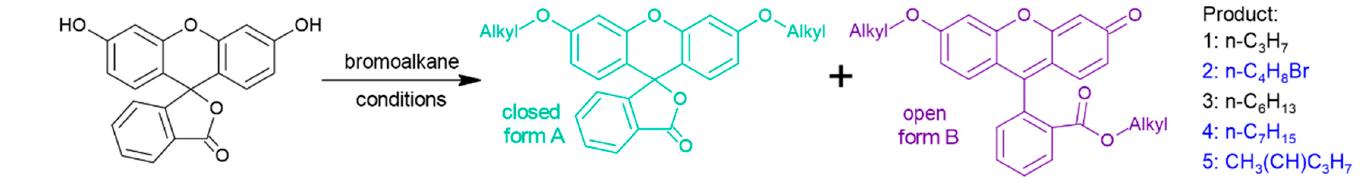
Figure 2. Preparation scheme of long chain alkyl derivatives (product A (3 ′ ,6 ′ -dialkyloxy derivative) —closed lactone ring; product B (2,6 ′ -ether–ester)—opened lactone ring) (top) with magnification —closed lactone ring; product B (2,6 (cid:48) -ether–ester)—opened lactone ring) (top) with magnification on on new, long alkyl chain fluorans (bottom). Conditions: Cs 2 CO 3 , DMF, 70 °C, 24 h for classical heat- new, long alkyl chain fluorans (bottom). Conditions: Cs 2 CO 3 , DMF, 70 ◦ C, 24 h for classical heating ing method; Cs 2 CO 3, DMF, 70 °C, 10 min for microwave-assisted method; Cs 2 CO 3, TBAB, 18-crown- method; Cs 2 CO 3, DMF, 70 ◦ C, 10 min for microwave-assisted method; Cs 2 CO 3, TBAB, 18-crown-6, 6, 1 h for ball-mill assisted method. 1 h for ball-mill assisted